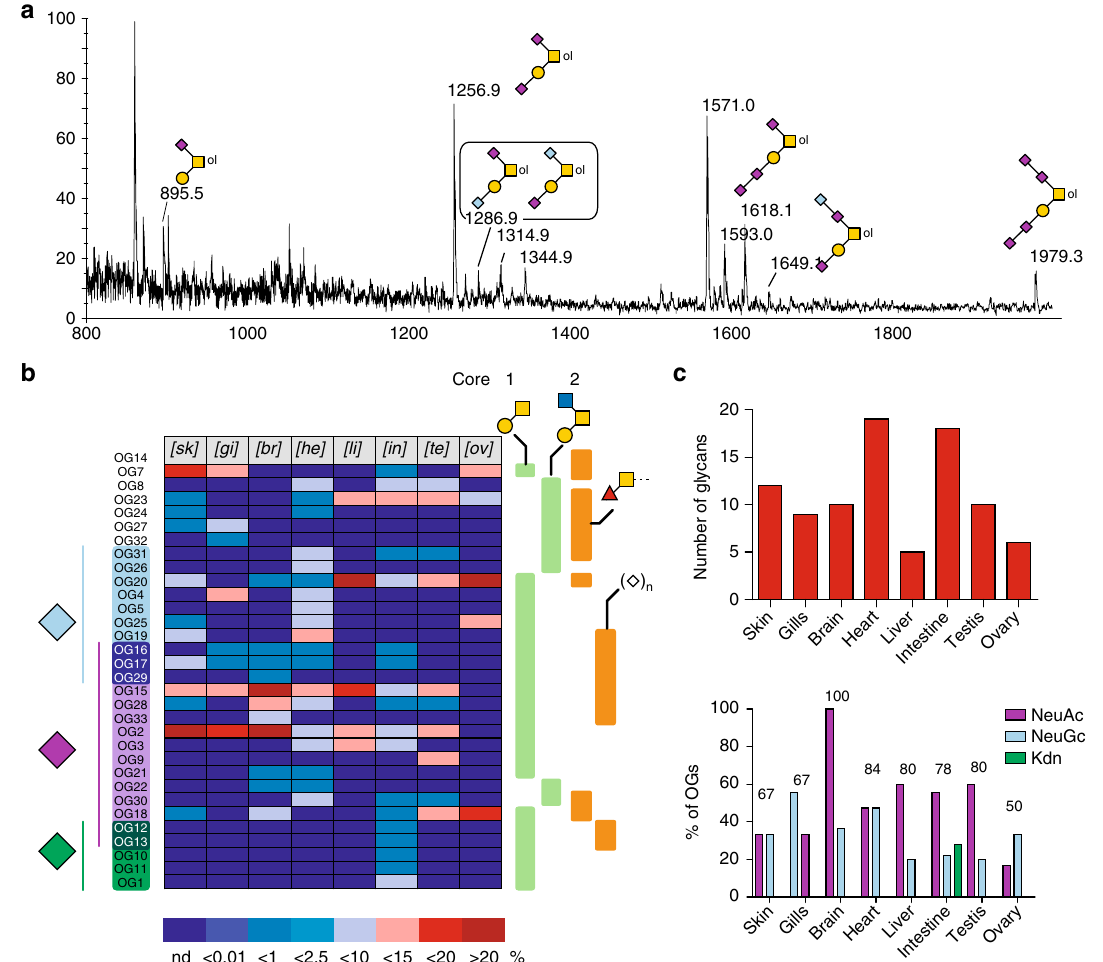
Fig. 5 O -glycome pro fi les. a Representative MALDI-TOF MS spectra of permethylated OGs isolated from brain. All MS spectra are provided in Supplementary Figure 4. b Tissues-speci fi c distribution and relative quanti fi cation of OGs according to following glycan epitopes: nature of substituting sialic acids (Neu5Ac, Neu5Gc, Kdn), core-1 Gal β 1-3GalNAc, Core-2 Gal β 1-3(GlcNAc β 1-6)GalNAc, Fuc α 1-3GalNAc β , and oligosialylation. The nature of individual glycans was established by a combination of MS/MS, GC/MS, and NMR, in comparison with previous work 28,29 . Tissue-speci fi c distribution of glycans is presented in Supplementary Data 2. Relative quanti fi cations of individual compounds were extracted from dataset presented in Supplementary Figure 5. c Number of OGs identi fi ed in each organ (upper panel) and proportion of sialylated OGs in each organ expressed as the percentage of OGs substituted by any of the three sialic acids (purple bars, Neu5Ac; light blue bars, Neu5Gc; green bars, Kdn); numbers indicate the overall percentage of sialylated OGs relative to total OGs in the corresponding organs. It should be noted that a single OG may bear different types of